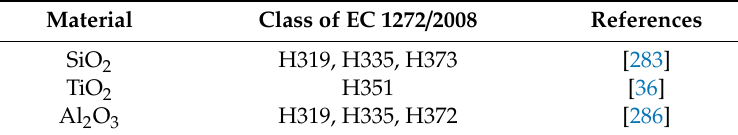
Table 10. Hazard statements of SiO 2 , TiO 2 , and Al 2 O 3